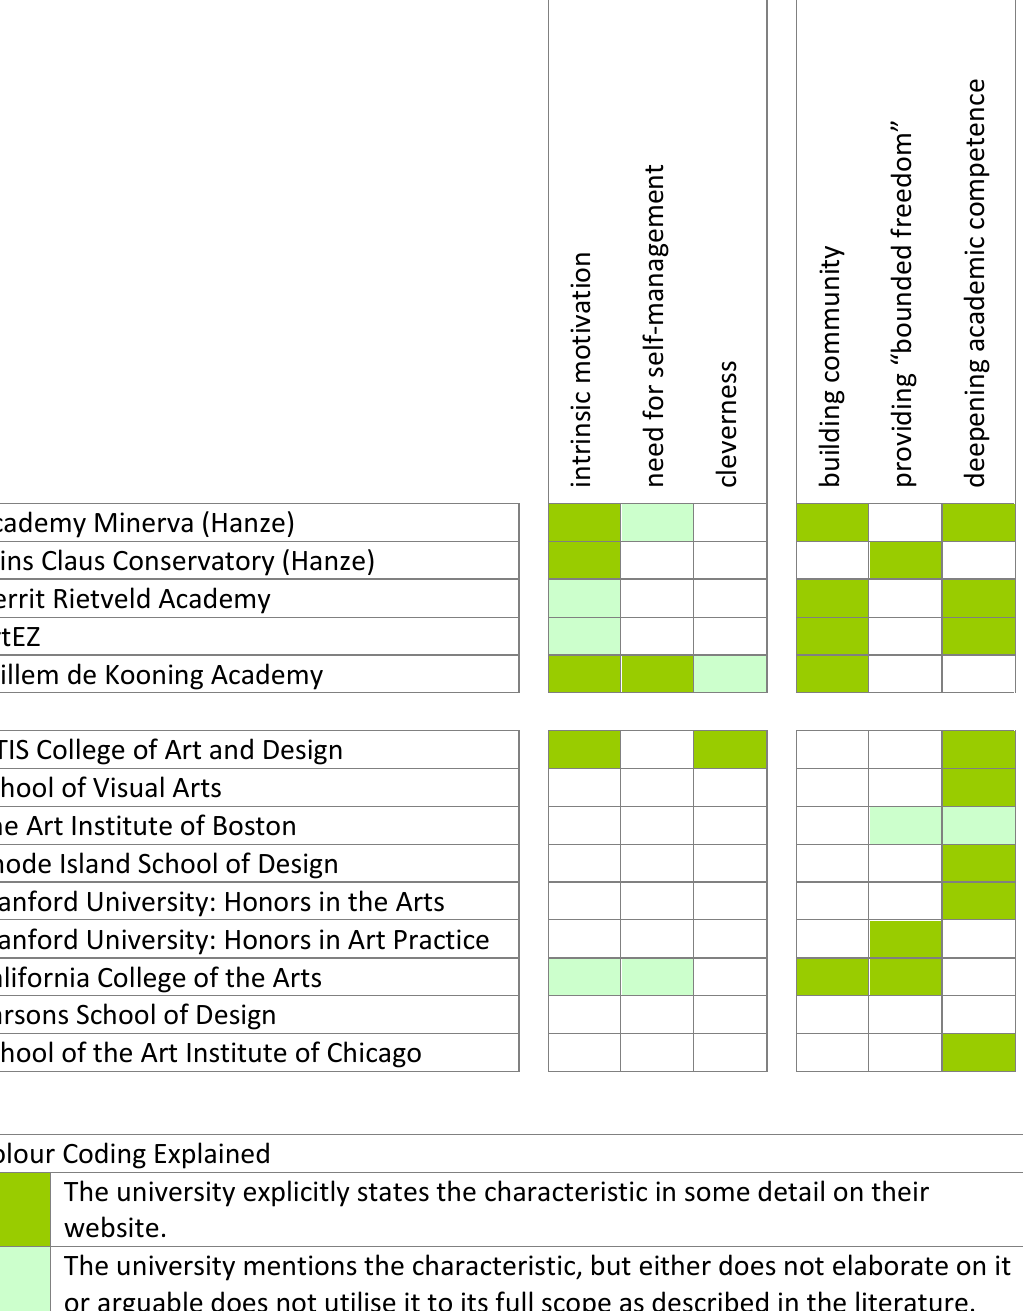
Table 4: Positioning of Universities of the Arts in relation to the Literature on Excellence Students